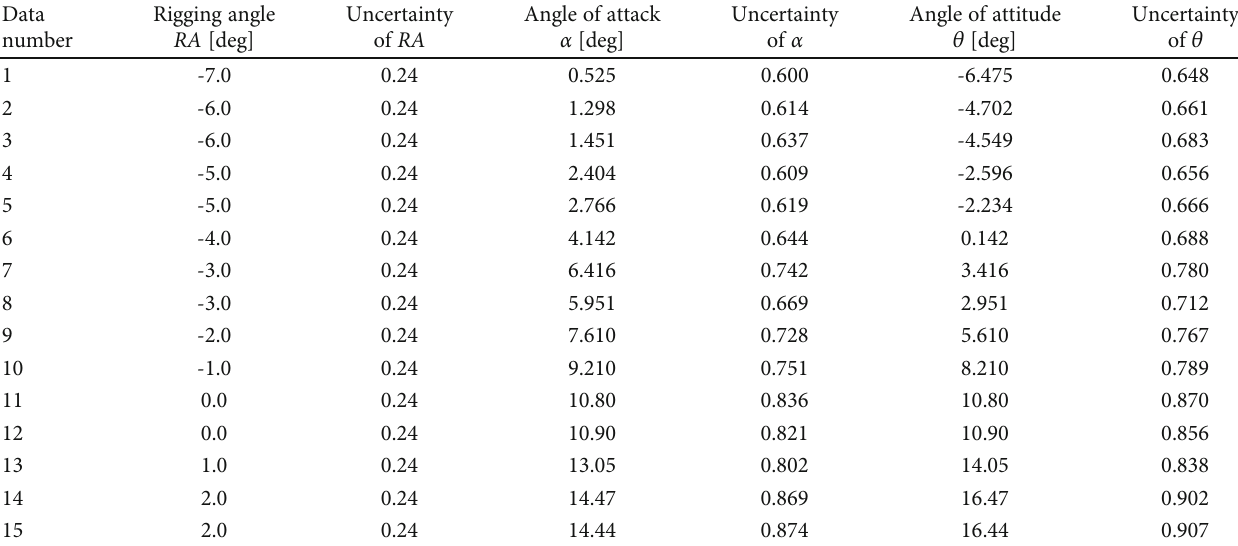
Table 10: Wind tunnel test result of 120Pa wind